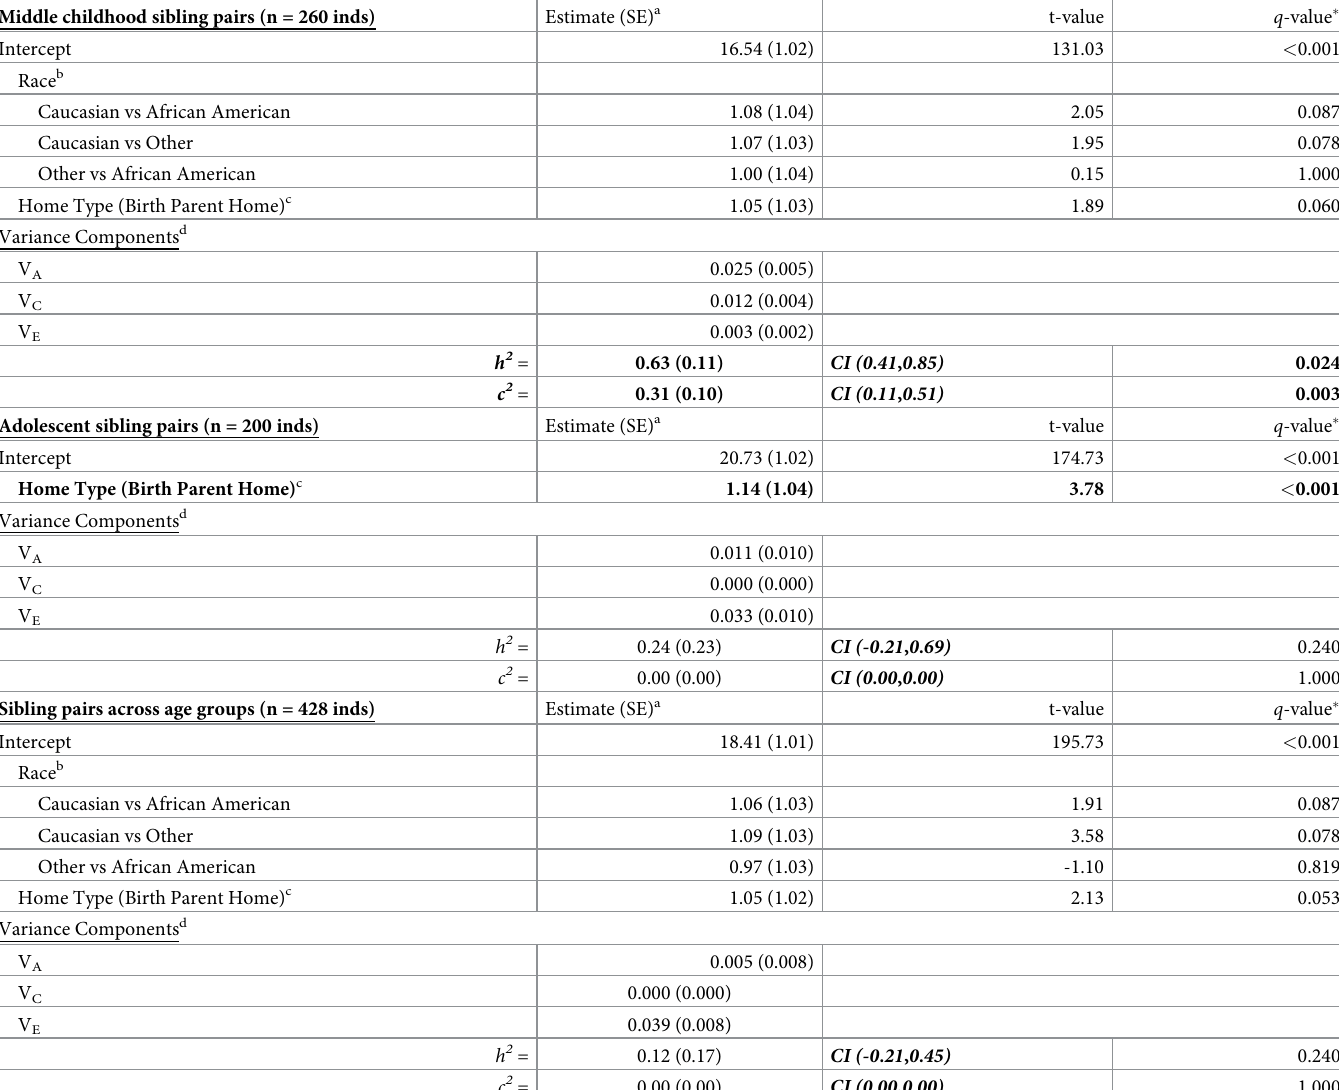
Table 3. Heritability of child body mass index (BMI) by age